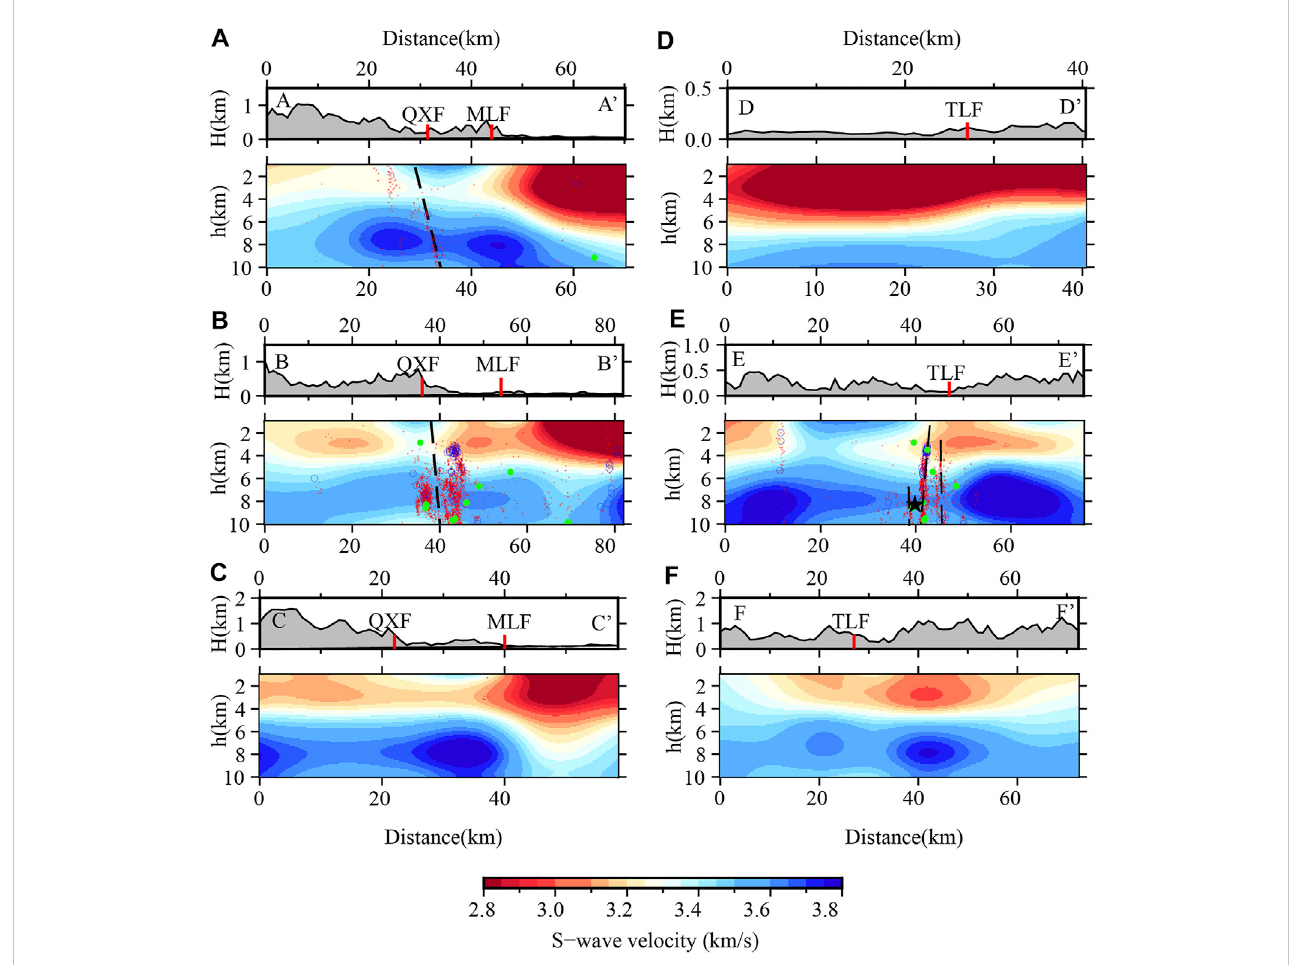
FIGURE 9 Shear wave velocity structure in different vertical pro fi le (A – F) shown in Figure 2 (The red and blue circles are the small earthquakes of ML0-1.9, 1.9 – 2.9, respectively;thegreendotsrepresentearthquakesaboveML3.Theblackstarrepresentsthe2014HuoshanM4.3earthquake.Blackdashedlinesrepresentthe inferred fault under the